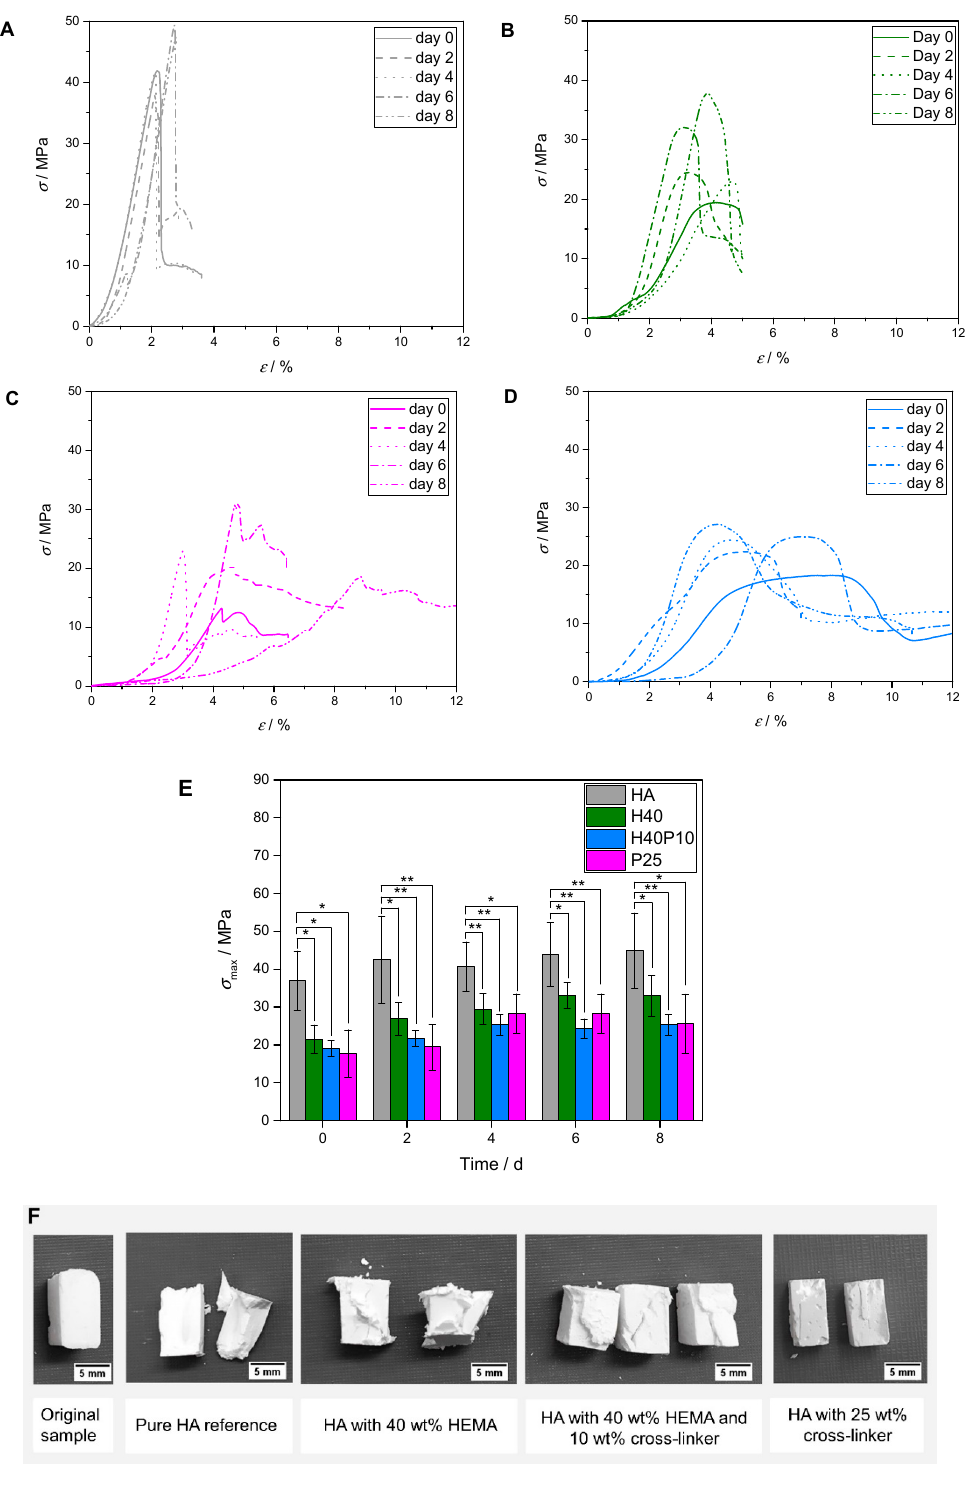
Figure 11. Stress-strain curves of inorganic reference in comparison to composite materials as well as overview of maximum stress-values over 8 d. A : Inorganic reference (HA) with typical brittle behavior—high initial stress with low strain-levels. B: Formulation containing 40 wt% HEMA in liquid phase (H40) showing an increase in ductility with high stress-values comparable to pure HA cement. C: Samples based on 25 wt% cross-linker (P25) with increase in ductility. D: Most ductile system composed of HEMA (40 wt%) and hydrogel precursor (10 wt%) with plateau phases instead of maximum stress peaks and deformations up to 10%. E: Maximum stress of all batches during time frame of 8 d. Image F depicts specimens before and after compressive strength testing at day 0. * p < 0.05; ** p < 0.001.